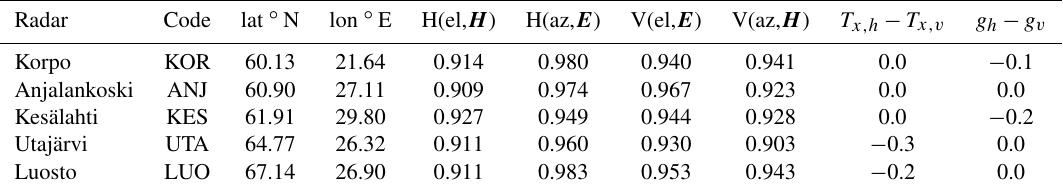
Table 1. Some properties of the FMI radars relevant to this study. The columns give the radar name, three letter acronym, latitude and longi- tude of the radar, the antenna beam widths for the horizontal polarization (H) and vertical polarization (V) in elevation and azimuth directions in degrees, the difference of losses in the transmitter chain ( T x ) indB, and difference of the antenna gains ( g ) indB. The beam widths in the elevation and azimuth directions are based on measurement of the electric ( E ) and magnetic fields ( H ) as indicated in parentheses. Radar Code lat ◦ N lon ◦ E H(el, H ) Korpo